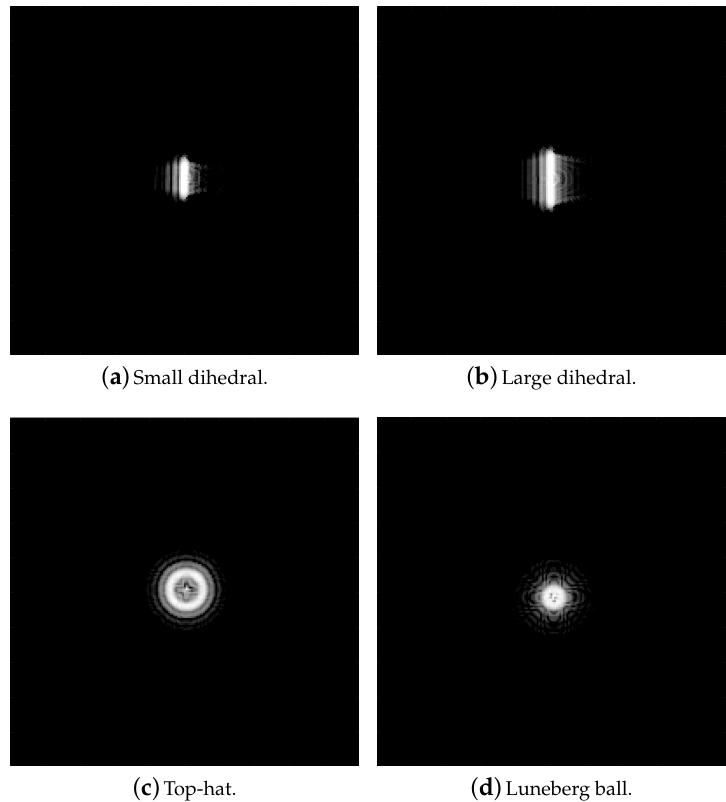
Figure 2. 360 ◦ coherent complex SAR images of targets. ( a ) Small dihedral. ( b ) Large dihedral. ( c ) Top-hat. ( d ) Luneberg ball.